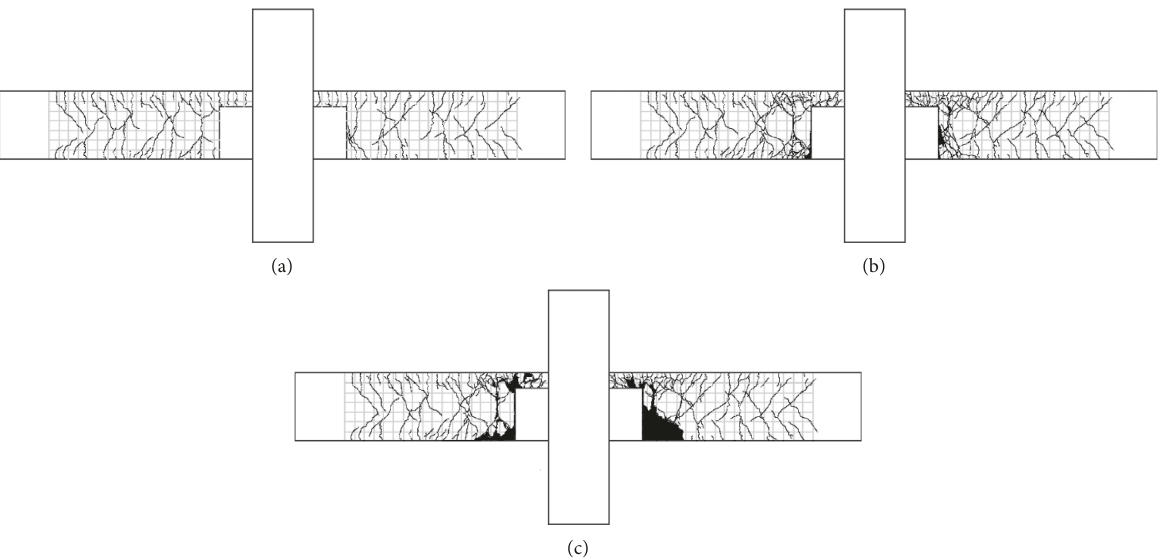
Figure 10: Crack development process of SUJD: (a) yielding stage, (b) peak load stage, and (c) failure